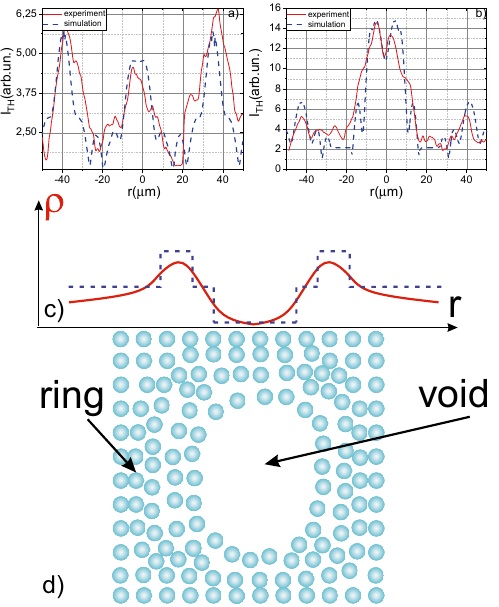
Figure 3. Dependence of the third harmonic intensity on the radial shift from the center for micromodification with ( a ) 3.4 μm and ( b ) 7.2 μm in diameter. ( c ) Radial profile of density (solid red curve) in microvoid and used for the profile of third-order nonlinear susceptibility χ (3) in the XY-plane (z is an optical axis) used in the simulations. ( d ) Visualization of microvoid profile in XY-plane.